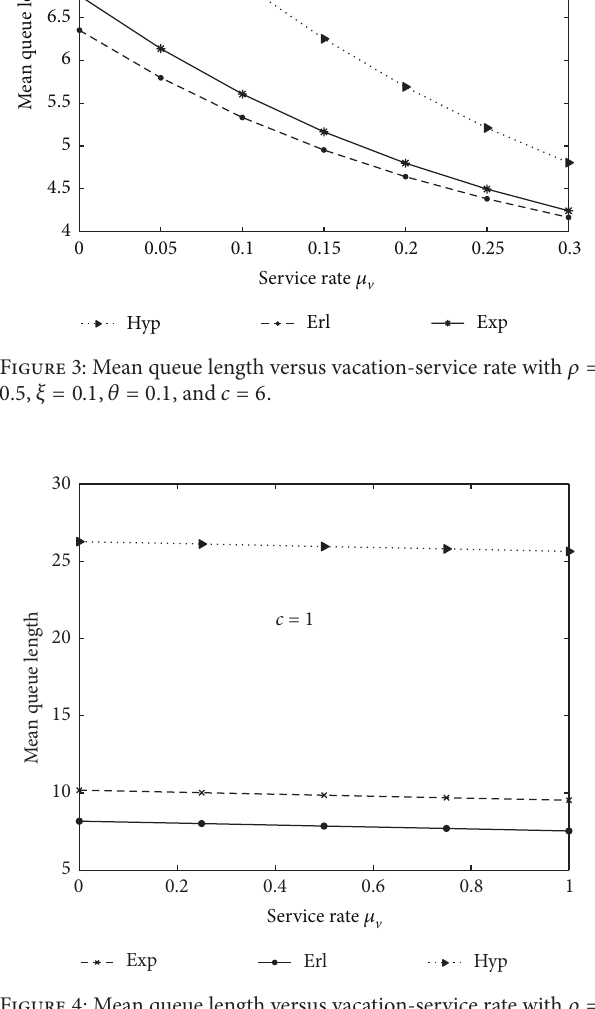
Figure 4: Mean queue length versus vacation-service rate with 𝜌 = 0.9 , 𝜉 = 1 , 𝜃 = 1 , and 𝑐 = 1